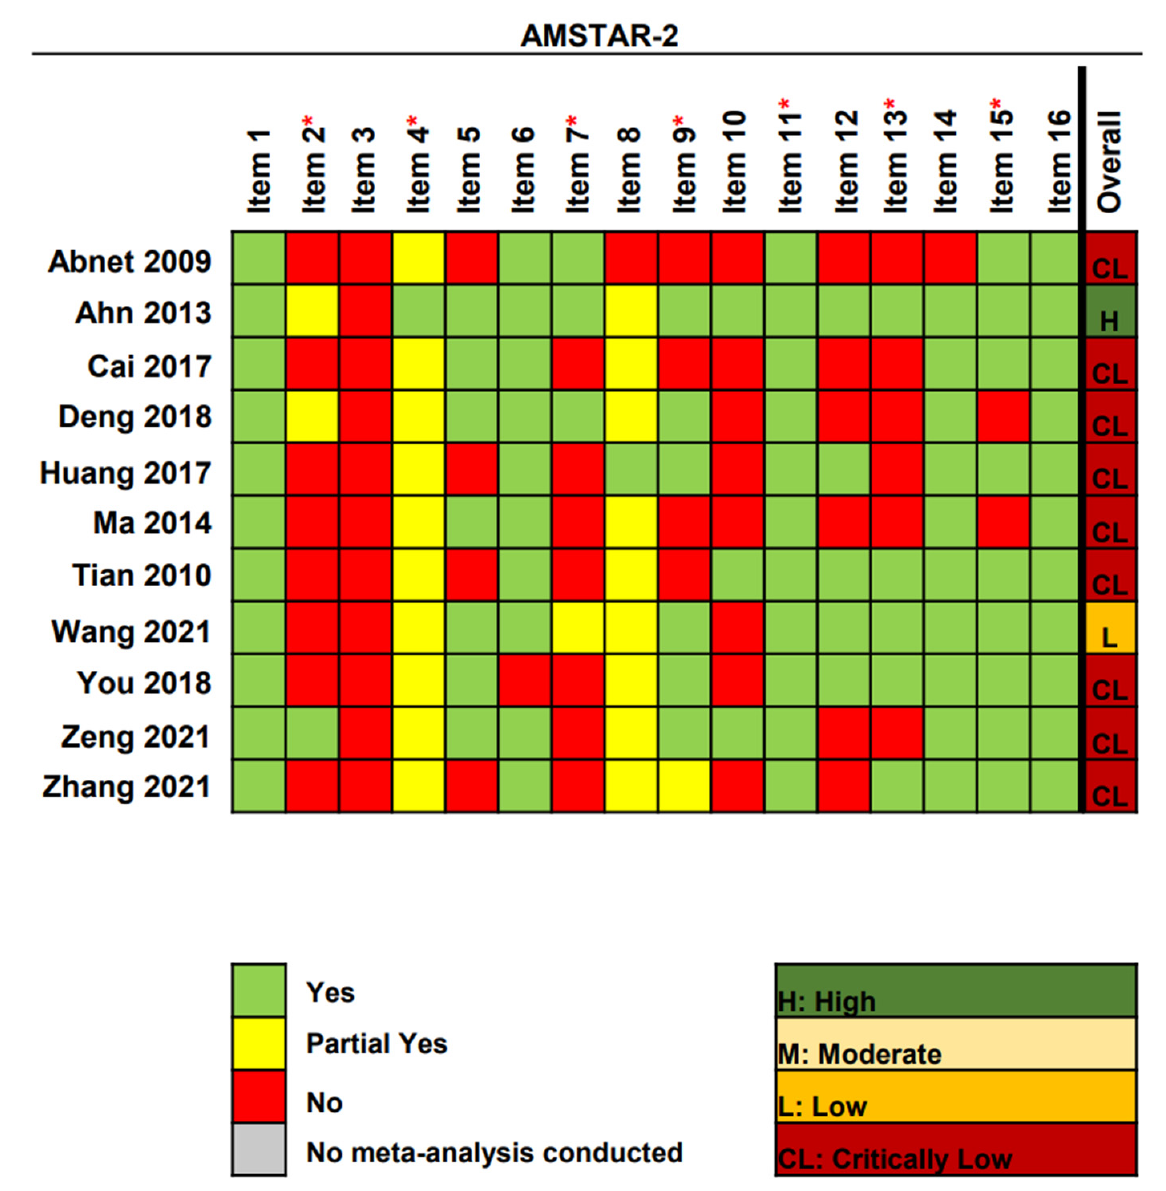
Figure 3. Methodological quality of the included systematic reviews [40–50]. Abbreviations: AMSTAR-2, A Measurement Tool to Assess Systematic Reviews-2; * Critical domain.